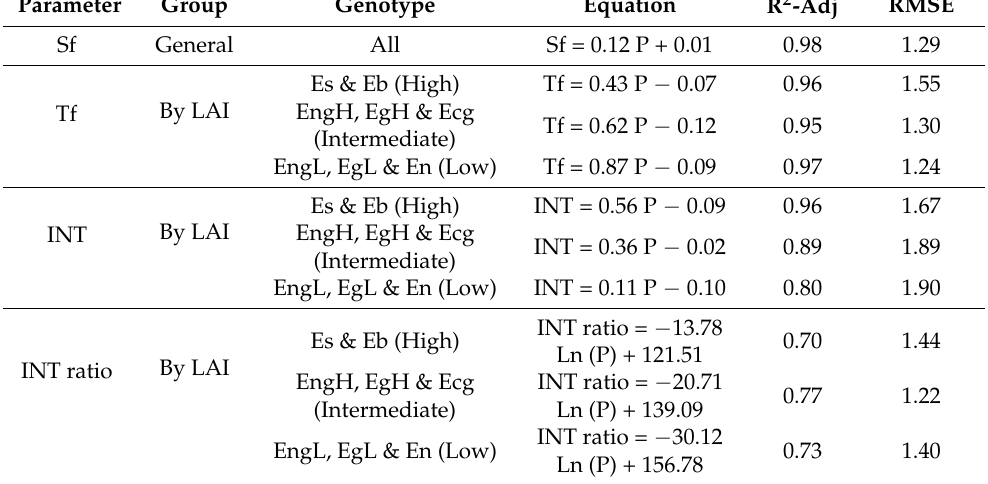
Table 1. Adjusted models coefficients and statistical criteria values for throughfall (Tf), Stemflow (Sf), rainfall interception (INT) and rainfall interception ratio (INT ratio) variables for all evaluated Eucalyptus